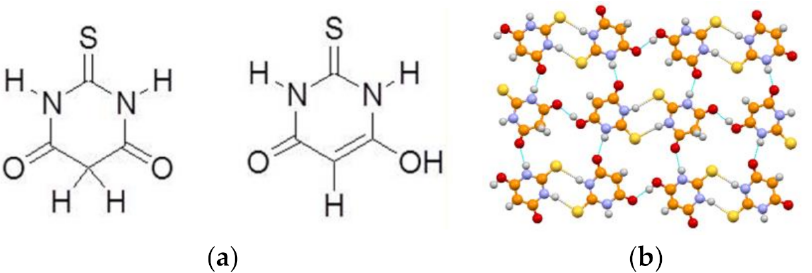
Figure 10. ( a ) Keto/enol tautomerism of thiobarbituric acid and ( b ) the crystal structure of the most stable form at room temperature, showing the presence of both the keto and enol forms